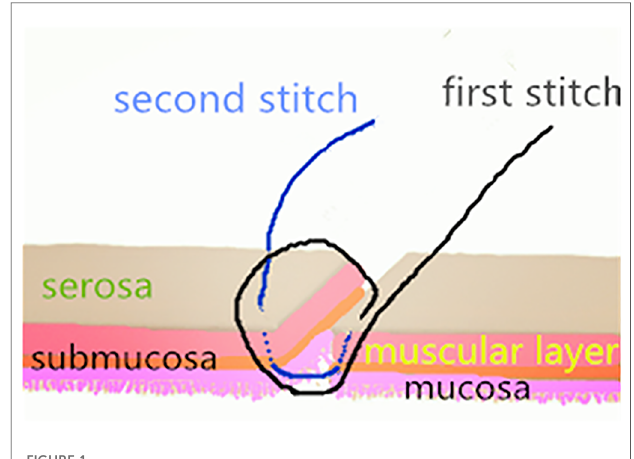
FIGURE 1 A schematic representation of the asymmetric fi gure-of-eight suture. The technique has been described in detail previously